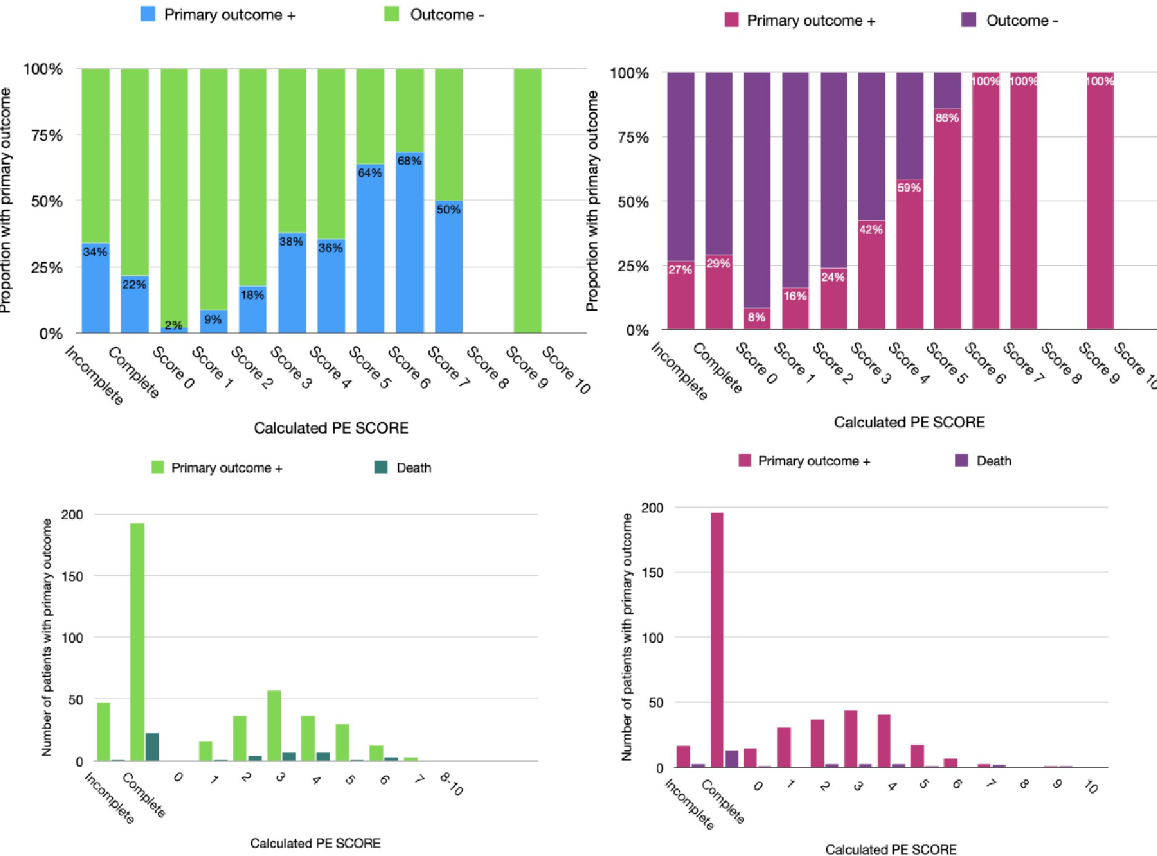
Fig 5. Proportions with primary outcome by calculated PE-SCORE. Legend: Panels A and B show 2D stacked column charts stratified by the proportions of patients with primary composite outcome positive (lower column) and the outcome negative groups (upper column) for each PE-SCORE calculation in the development and validation databases. Panels C and D show column charts for the number of patients with primary outcome positive next to the number with death for each PE-SCORE calculation in the development and validation